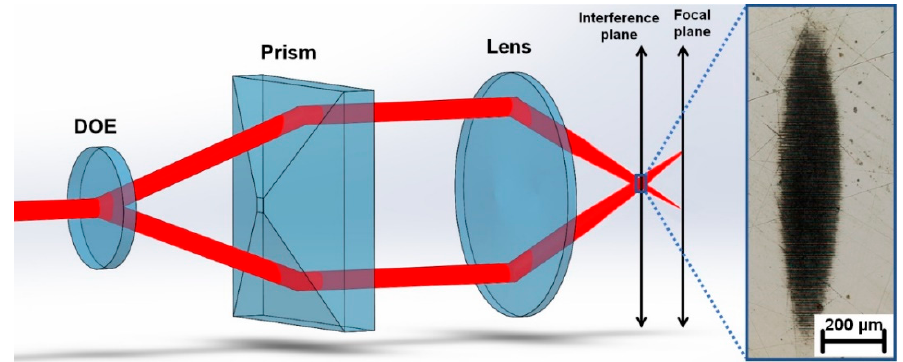
Figure 2. Illustration of the experimental setup with a marked shift between the interference and focal plane and with an inset of the elongated spot shape fabricated on a stainless-steel sample.